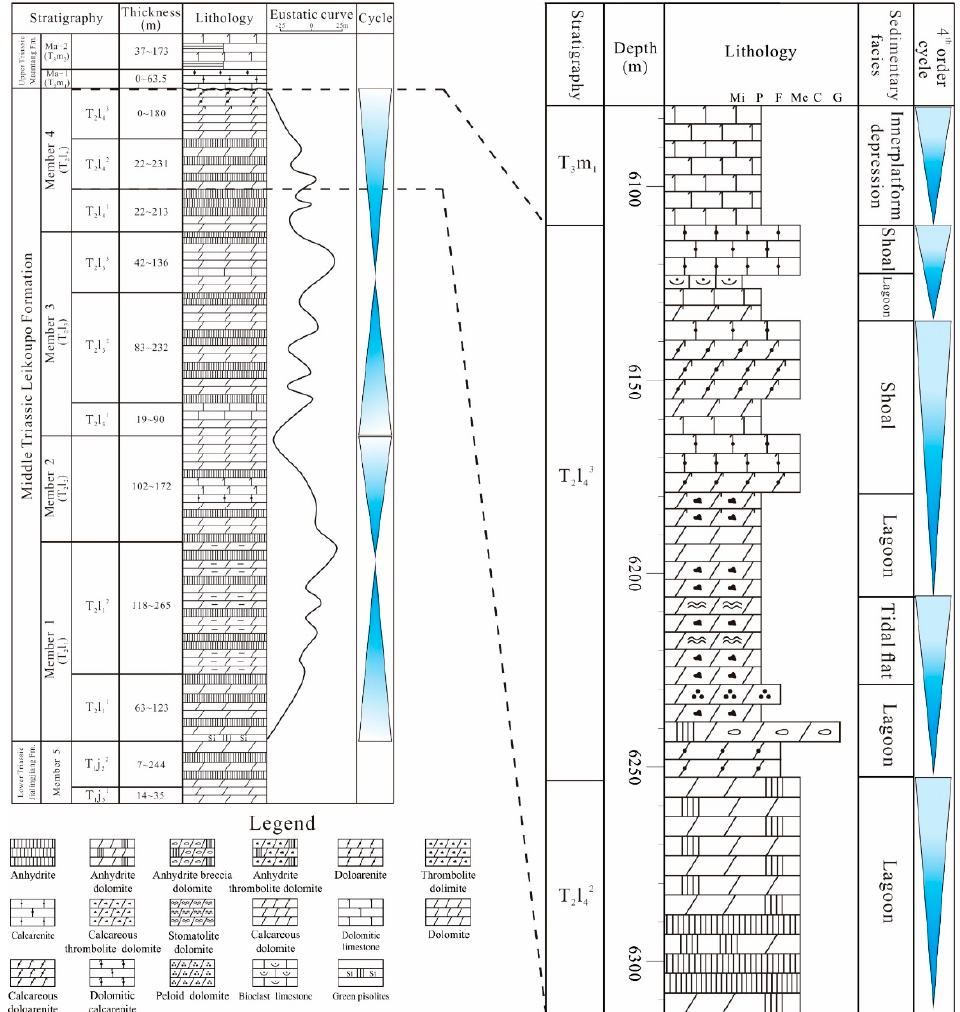
Figure 2. Sequence stratigraphy and lithology of the Leikoupo Formation in the Middle Triassic (modified from [34]), with an enlarged part showing the subdivision of the Member 4 of the Leikoupo Formation (Well Yangshen-1). T 2 l 11 = lower sub-member of Lei-1; T 2 l 12 = upper sub-member of Lei-1; T 2 l 2 = Lei-2; T 2 l 31 = lower sub-member of Lei-3; T 2 l 32 = middle sub-member of Lei-3; T 2 l 33 = upper sub-member of Lei-3; T 2 l 41 = lower sub-member of Lei-4; T 2 l 42 = middle sub-member of Lei-4; T 2 l 43 = upper sub-member of Lei-4. ‘Mi’ = micrite; ‘P’ = powder; ‘F’ = fine; ‘Me’ = Medium; ‘C’ = coarse; ‘G’ = gravel.